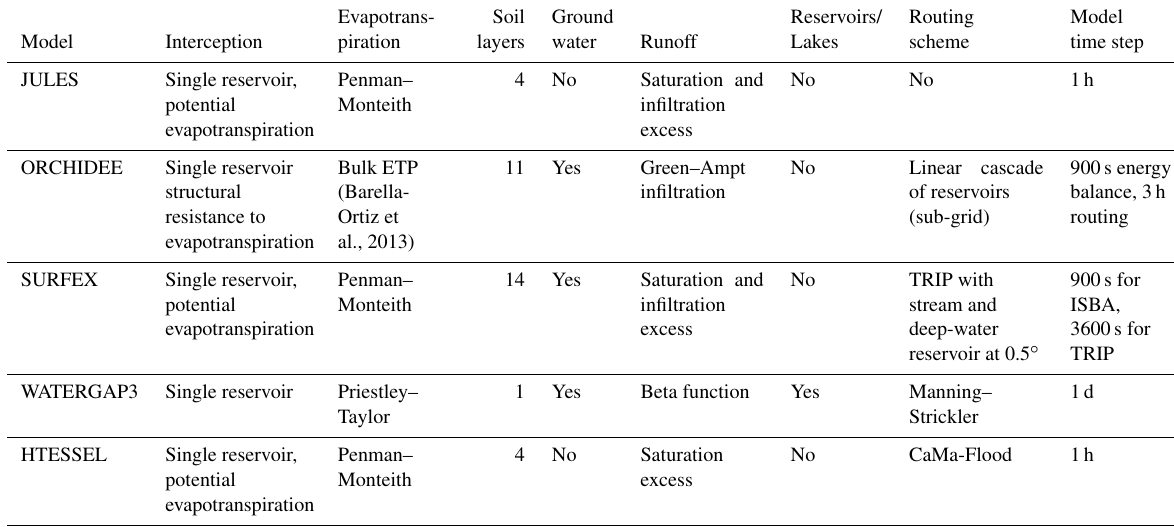
Table A2. Details of the modeling